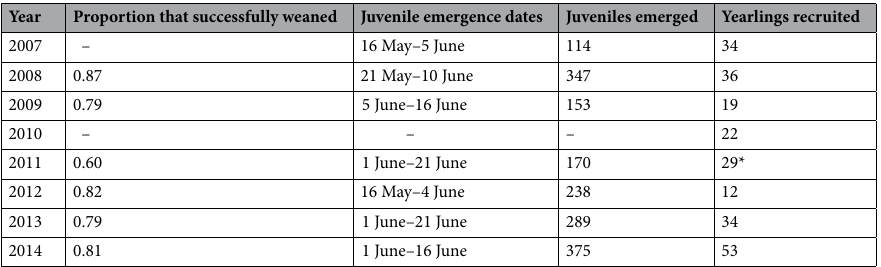
ranged from 3.5 °C (25 March) to 21.1 °C (18 March) above the 5-year average, for a mean of 12.9 °C above the 5-year average. Data collection and analysis. Following euthanasia, we measured body mass with a spring scale (Pesola, Baar, Switzerland) to ± 1.0 g and measured spine length from the occipital condyles to the base of the caudal vertebrae to ± 0.1 cm with a tape measure. Scrotum skin colour typically changes from a lighter, pinkish col- scrotum colour as either pink or darkly-pigmented (dark gray or black). We removed the testes, epididymis and accessory glands, and used an MXX-212 Denver digital scale (Bohemia, NY, USA) to record the mass of the testes, prostate, seminal vesicles and Cowper’s gland (to ± 0.01 g). We cut the epididymis in a petri dish with warm coconut water 59,60 and took a smear of sperm from the cauda epididymis within 5 min of euthanasia.